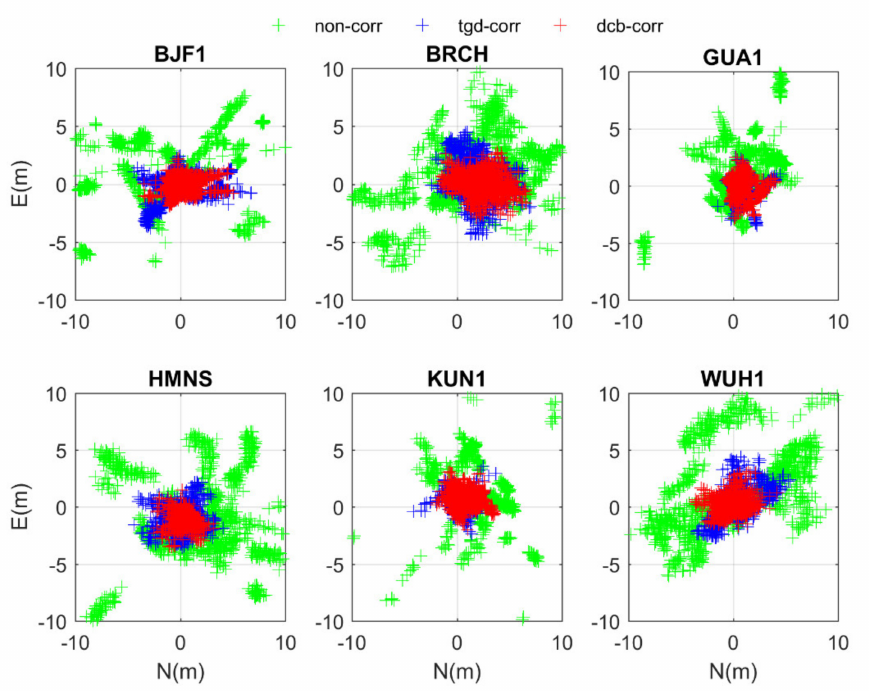
Figure 7. Horizontal positioning error scatters with and without TGD or DCB correction of B1C SPP at six stations.